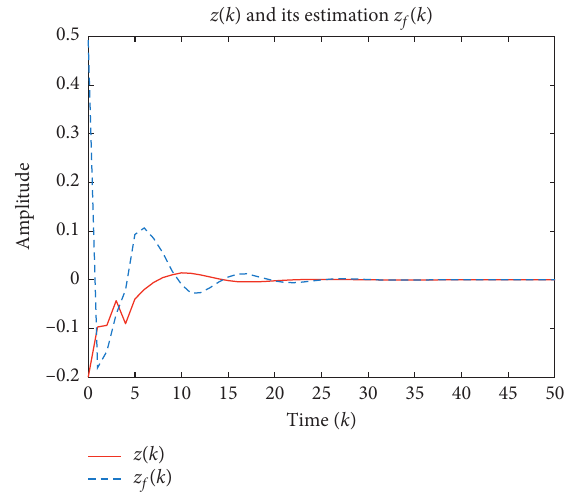
Figure 11: The response of z ( k ) and z